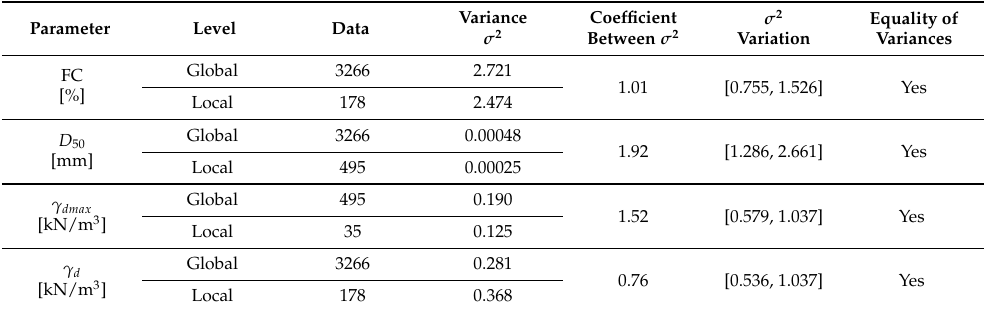
Table 6. Results from the test of equality of variances at global and local scales. Confidence level: 99.9%. Parameter Level